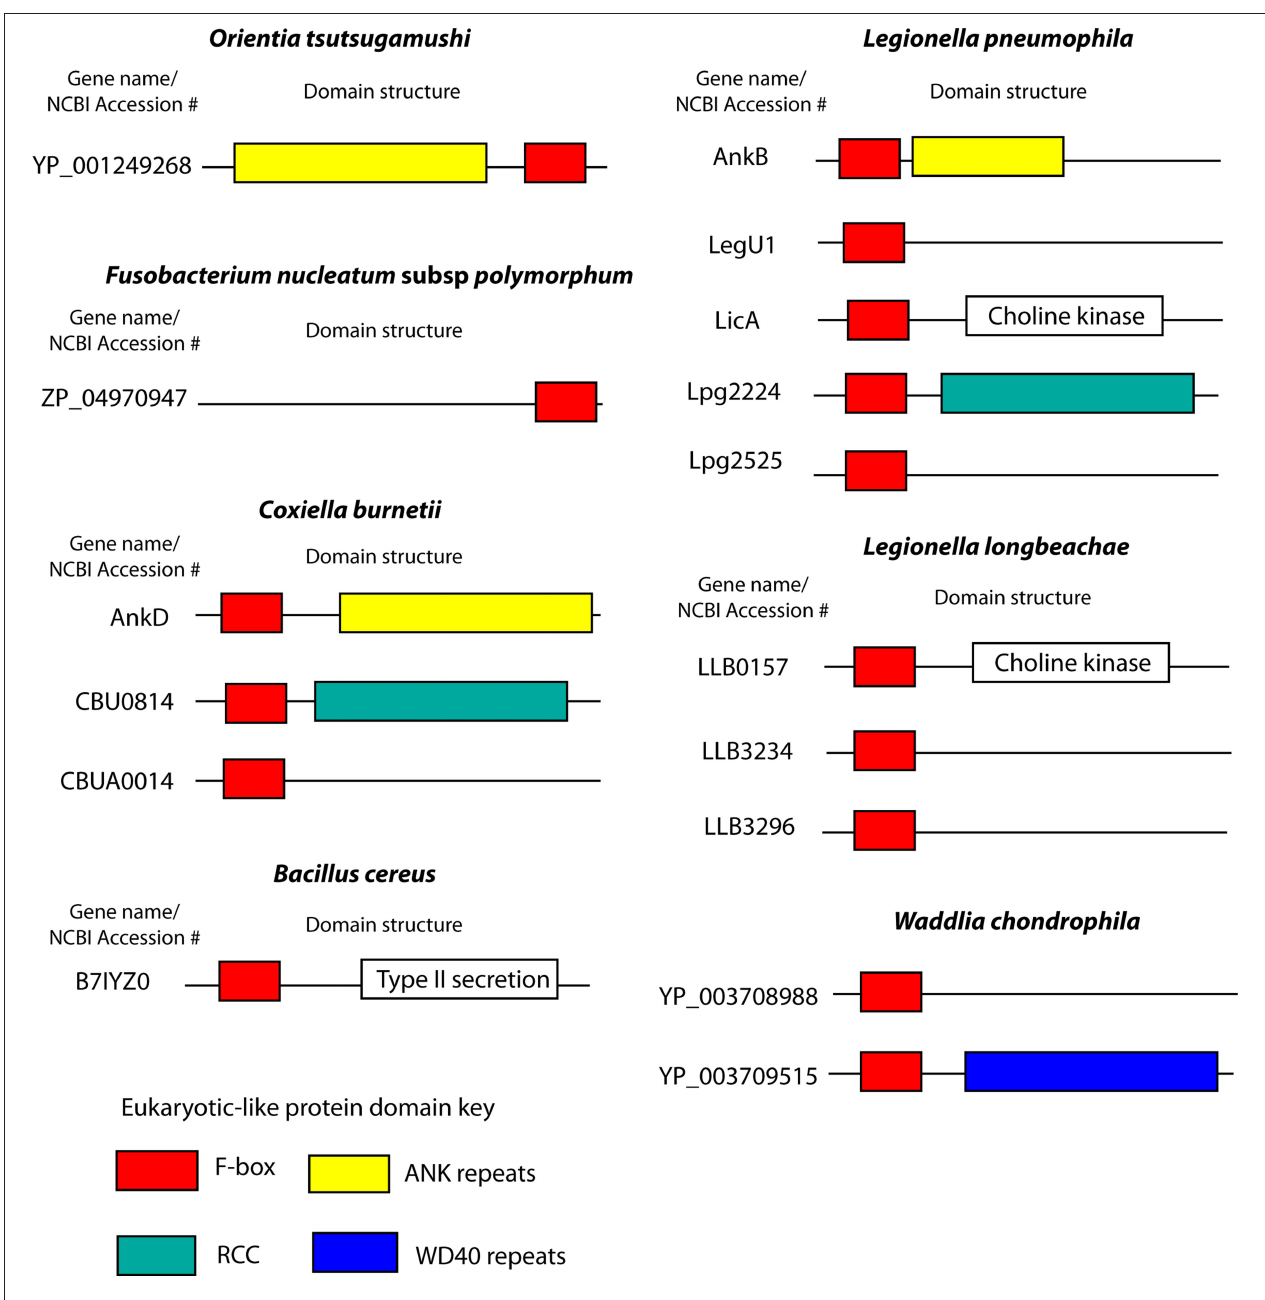
FiGure 4 | F-box proteins in human pathogens. Cartoon representations of the domain structures of bacterial F-box proteins found in human pathogens. Proteins and domain predictions were found at the EMBL-EBI website InterPro website (http://www.ebi.ac.uk/interpro), using the F-box domain motif IPR001810. Genes are identified by their name or NCBI accession